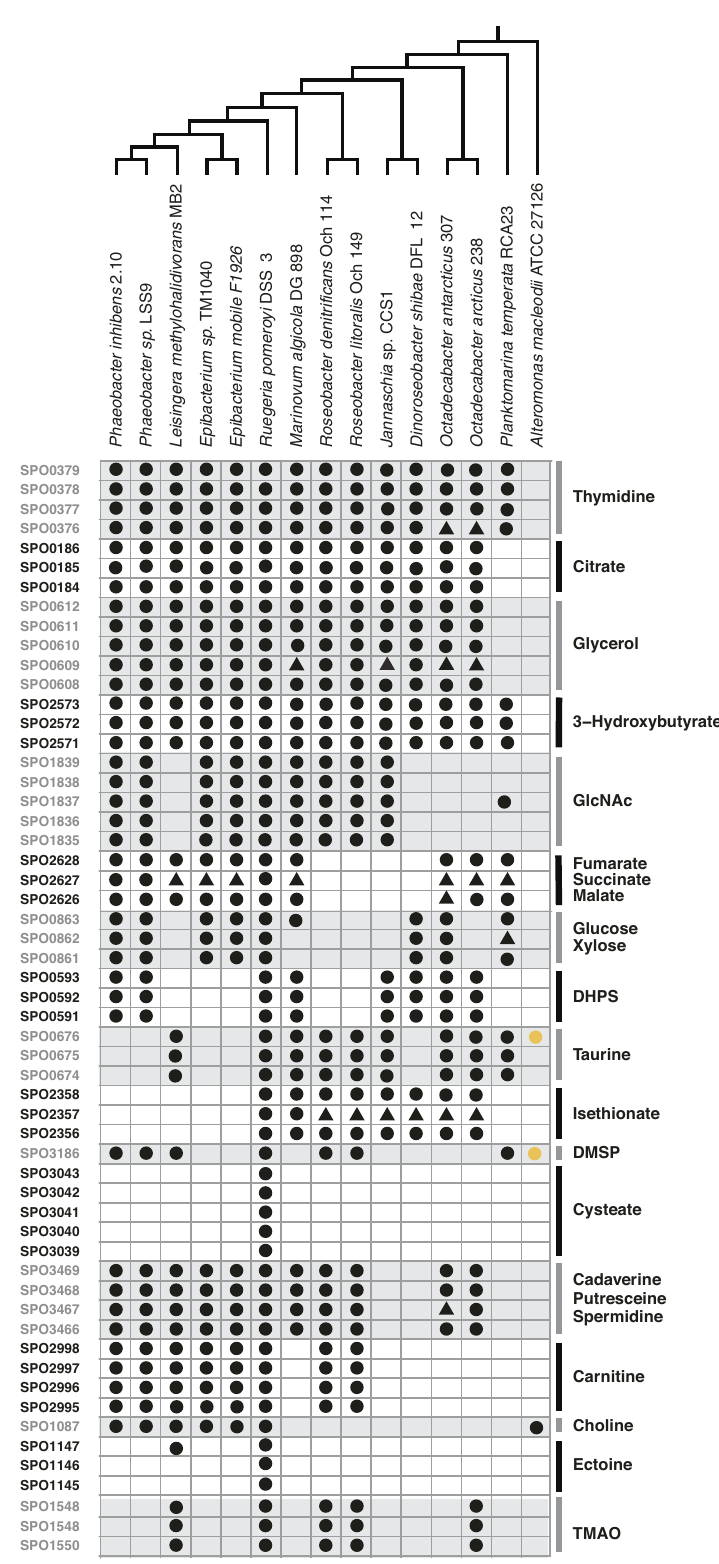
Fig. 5 Orthologs of the veri fi ed R. pomeroyi DSS-3 transporter systems in Roseobacter group members. Each row indicates a single gene and shading groups the genes that make up multi-component transporters. Black circles denote orthologs identi fi ed by BLASTp using e ≤ 10 -5 , identity thresholds ≥ 60%, and reciprocal best hit analysis. Black triangles denote orthologs of multicomponent transporters that did not meet the BLAST thresholds but were co-located in a transporter operon with components that did. Yellow circles denote potential orthologs in the outgroup A. macleodii ATCC27126 (identities <40%). Species phylogeny is based on analysis of 117 single copy